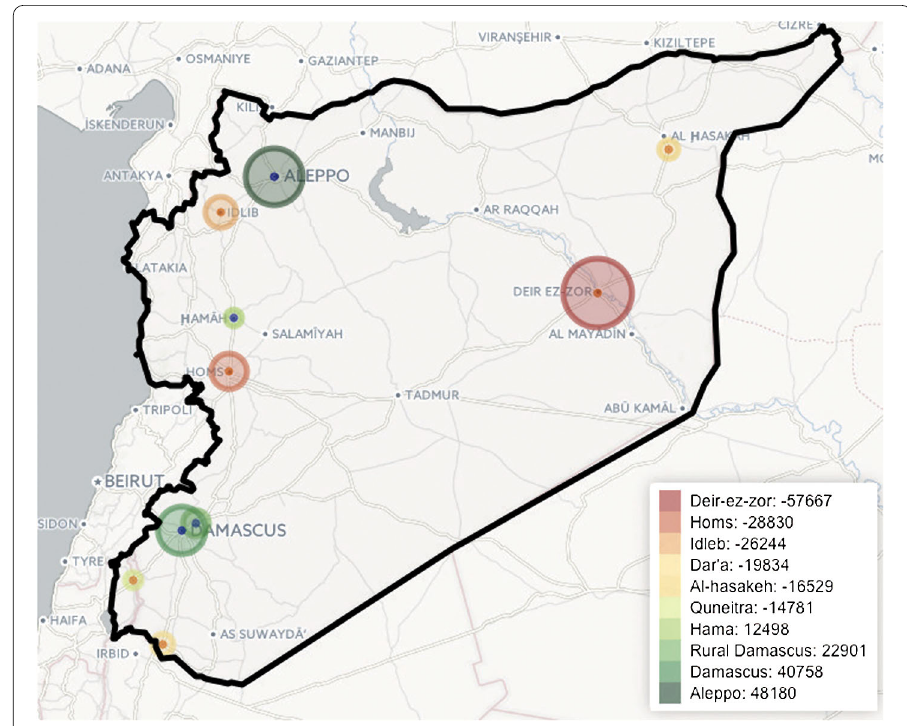
Figure 3 The map shows the districts’ center with a circumscribing circle whose radius is proportional to 1/ δ k and its color to the sign of the latter